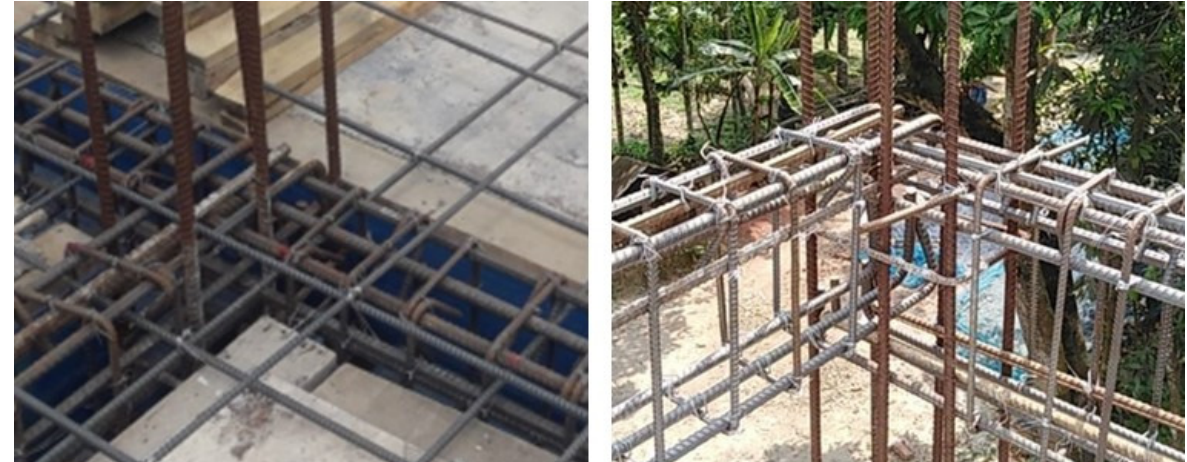
Figure 7. Typical locations of rebar congestion (used with permission from Khadem [23]).